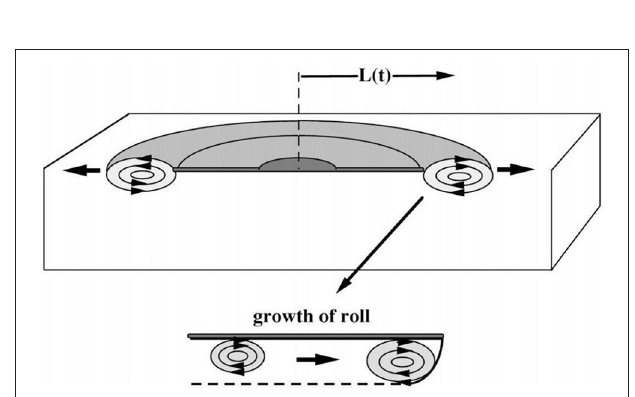
FIGURE 6 | Sub-surface flow in the water phase observed during volatile oil film spreading. Below a magnified view of stretched roll which produces flat thermal layer therein ( Dussaud and Troian,